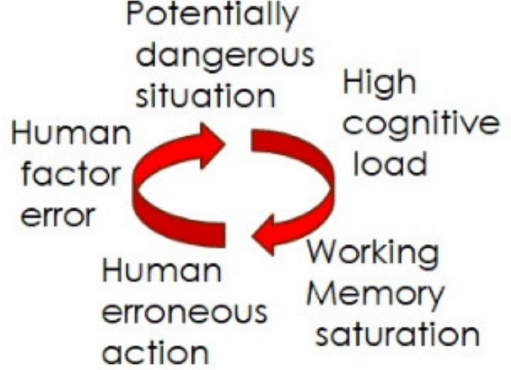
Figure 1. The high cognitive load results in human factor error and leads to the worst-case